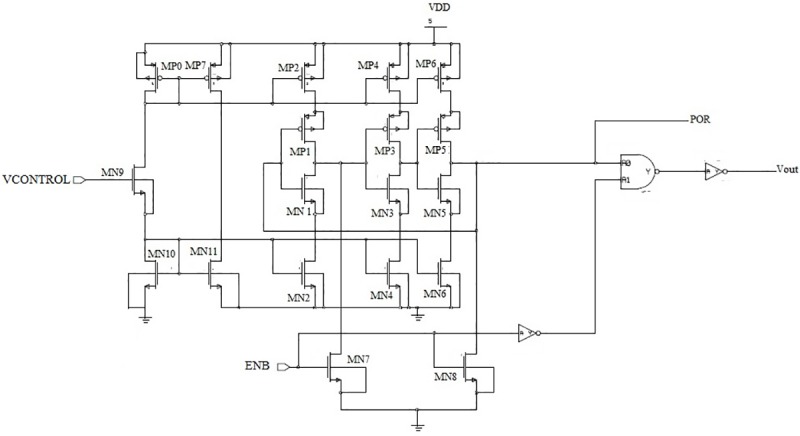
Schematic diagram of the current-starved ring oscillator (CSRO).